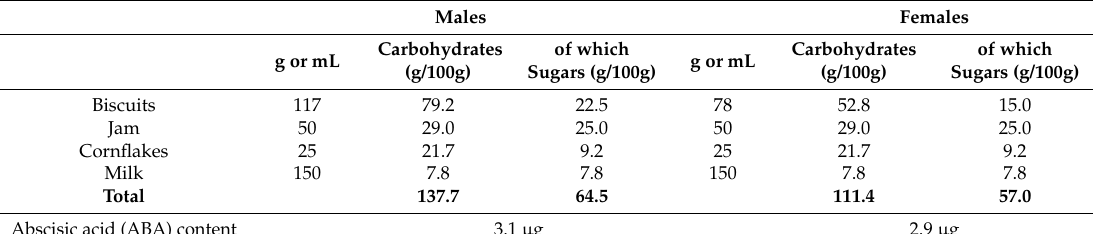
Table 2. Composition of the standardized carbohydrate-rich